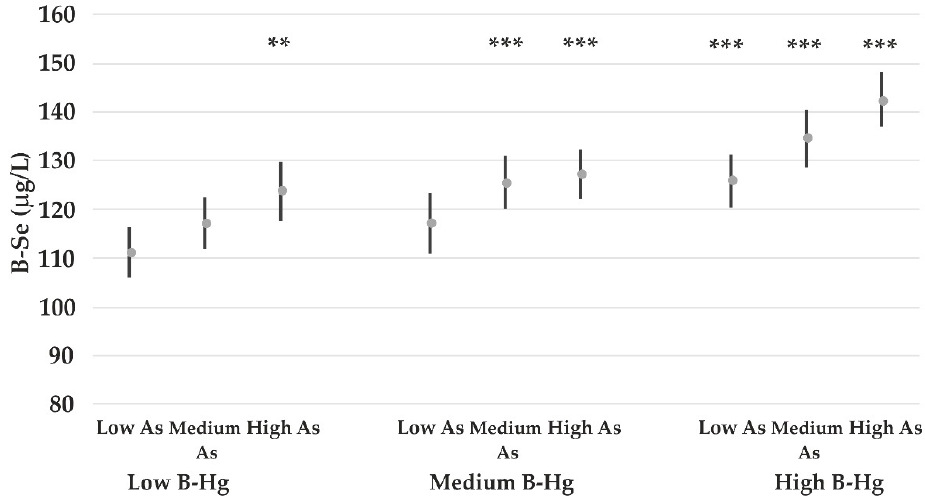
Figure 4. Arithmetic mean B-Se concentrations among all participants according to B-Hg stratified into tertiles (low 0.3–2.9 µg/L; medium 2.9–5.5 µg/L; high 5.5–24.3 µg/L) and B-As concentrations stratified into tertiles (low 0.5–3.5 µg/L; medium 3.5–8.8 µg/L; high 8.8–163 µg/L). The p -values (*** p < 0.001; ** p < 0.01) refer to comparisons with the subgroup comprising both low B-Hg and low B-As.